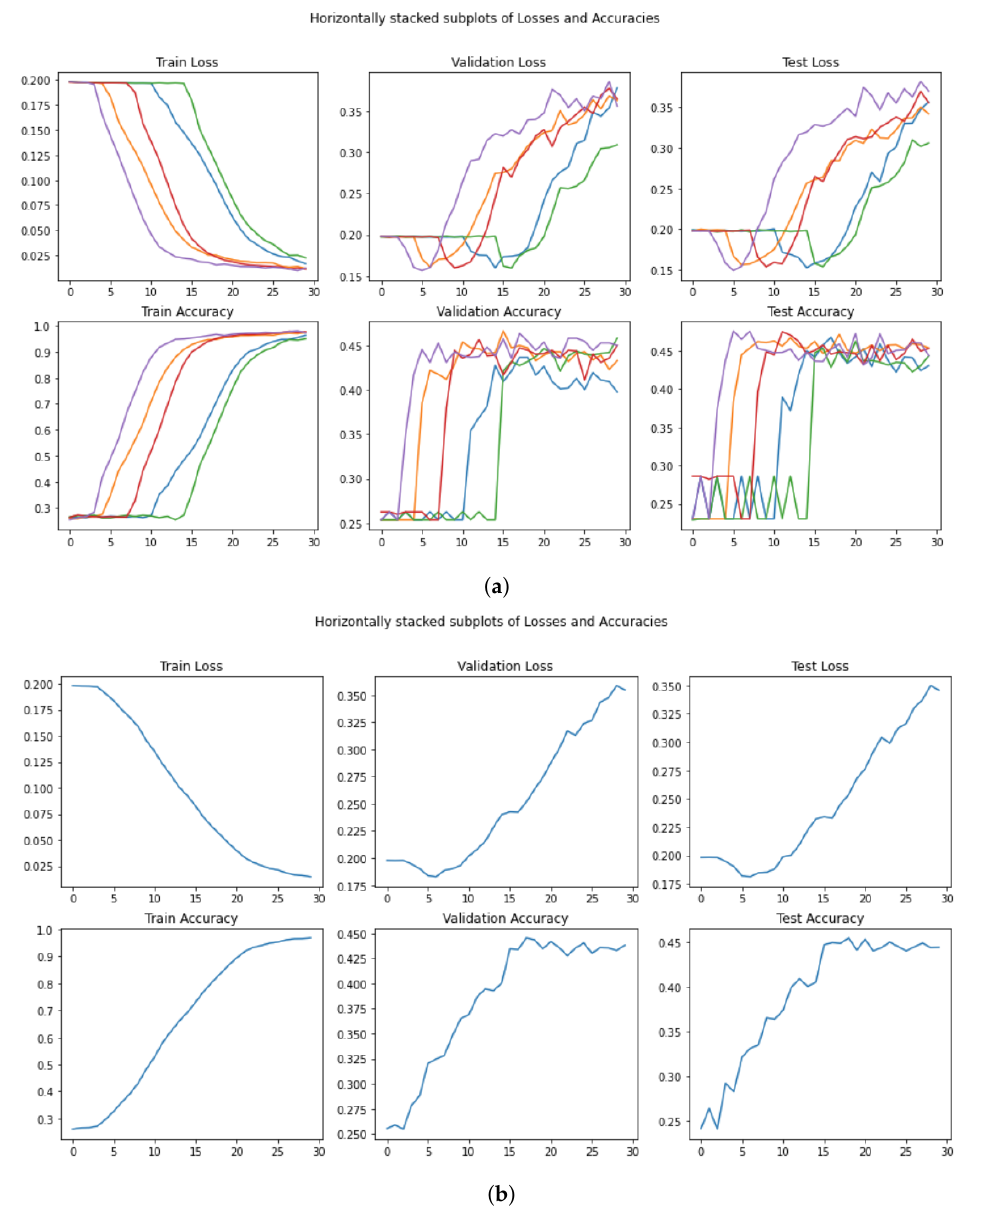
Figure 11. Performance in the training, validation, and test set for AlBERT. ( a ) Loss and Accuracy per run and per epoch. ( b ) Mean loss and mean Accuracy per